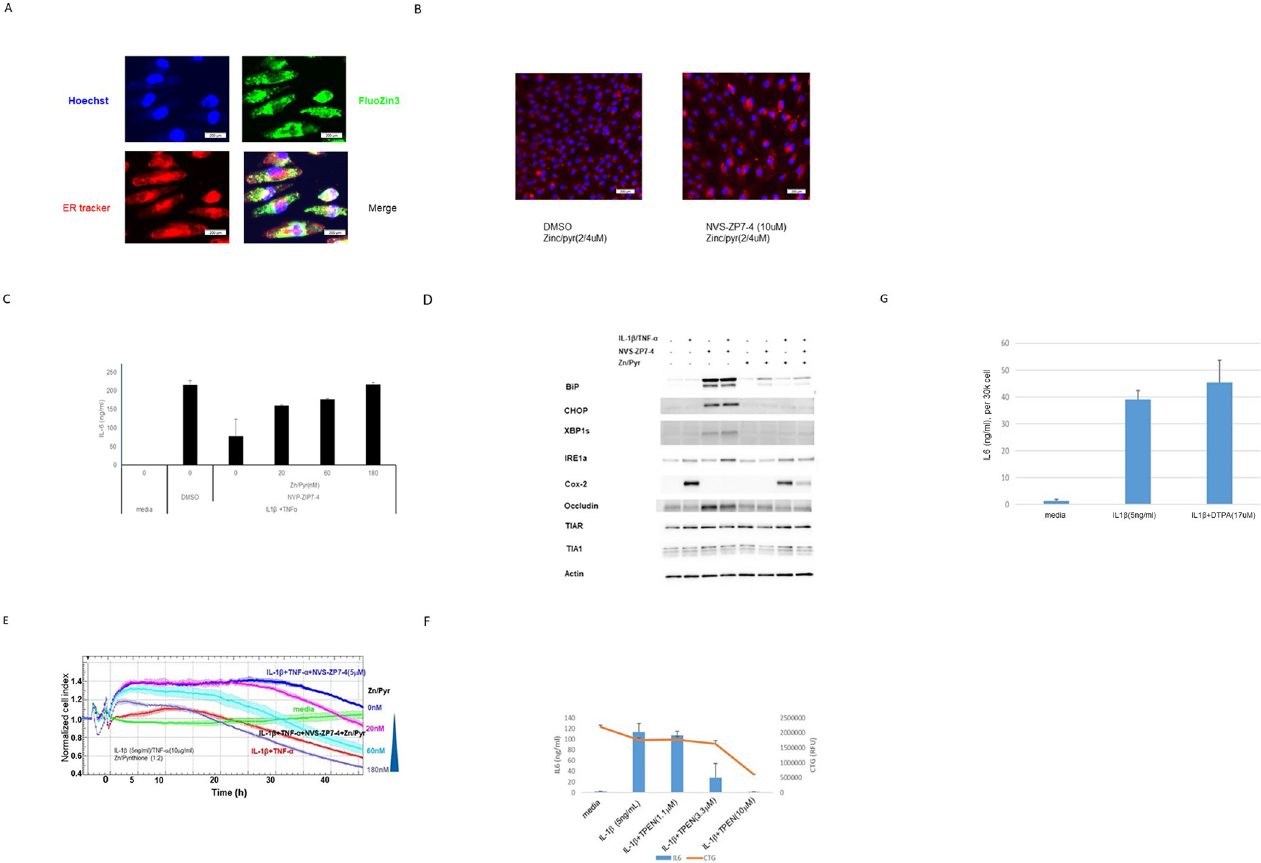
Fig 4. The role of Zn in signaling of IL-1 β /TNF- α or IL-1 β alone was confirmed using Zn ionophores or Zn chelators. A: ARPE-19 cells were treated with fluozin3 and ER tracker for 30min, then ZnCl2 (5 μ M) and sodium pyrithione (10 μ M) was added and cells were cultured for two more hours. Images were visualized with IN Cell Analyzer 2200 as described in the Methods section to visualize Zn levels in cells. Zn/Pyr increased Zn levels in the cell cytoplasm (green) and also in the ER (yellow). B: Cotreatment of ARPE-19 cells with Zn/Pyr and NVS-ZP7-4 increased Zn levels in the er as visualized with ZBR3. C: Cells were challenged with IL-1 β /TNF- α overnight in the presence of NVS-ZP7-4 and increasing concentrations of Zn/Pyr and IL-6 levels in the culture media were determined. Increasing Zn/Pyr restored IL-6 production induced by IL-1 β /TNF- α despite Zip7 inhibition with NVS-ZP7-4. D: Cells were treated with combinations of IL-1 β /TNF- α (10 ng/mL / 20 ng/mL) and western blotting analysis performed. Treatment of cells with 10 ng/mL IL-1 β and 20 ng/mL TNF- α induced Cox-2. Treatment of cells with NVS-ZP7-4 alone induced BiP, CHOP and sXBP-1 as well as occludin. Inclusion of NVS-ZP7-4 during cytokine treatment resulted in inhibition of Cox-2 induction and occludin and the er stress markers BiP, CHOP and sXBP-1. Cytokine treatment with NVS-ZP7-4 and Zn pyrithione resulted in a restoration of Cox-2 induction, and prevented induction of er stress markers and occludin. E: Increasing Zn/Pyr restored impedance loss induced by IL-1 β /TNF- α despite Zip7 inhibition with NVS-ZP7-4. The loss of impedance induced by challenge with IL-1 β /TNF- α was prevented by inclusion of NVS-ZP7-4 during the inflammatory challenge. If cytoplasmic Zn levels were restored using Zn/Pyr, impedance loss was induced by IL-1 β /TNF- α even in the presence of NVS-ZP7-4. F: The cell-permeable Zn chelator TPEN prevented overnight IL-6 induction by IL-1 β indicating intracellular Zn is essential for signaling. Cell toxicity was observed at 10 μ M TPEN. G: The cell-impermeable Zn chelator DTPA had no effect on overnight IL-6 induction by IL-1 β indicating extracellular sources of Zn are not required for signaling.